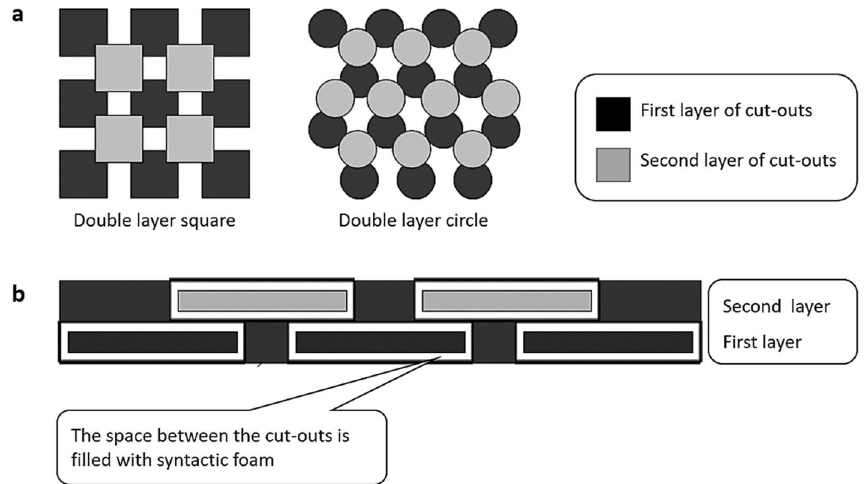
Fig. 3 A composite of aerogel fiber composite and foam in a wetsuit. a Cut‑out arrangements considered for constructing the hybrid insulation. b Cross‑section of double layer hybrid insulation (Bardy et al.,